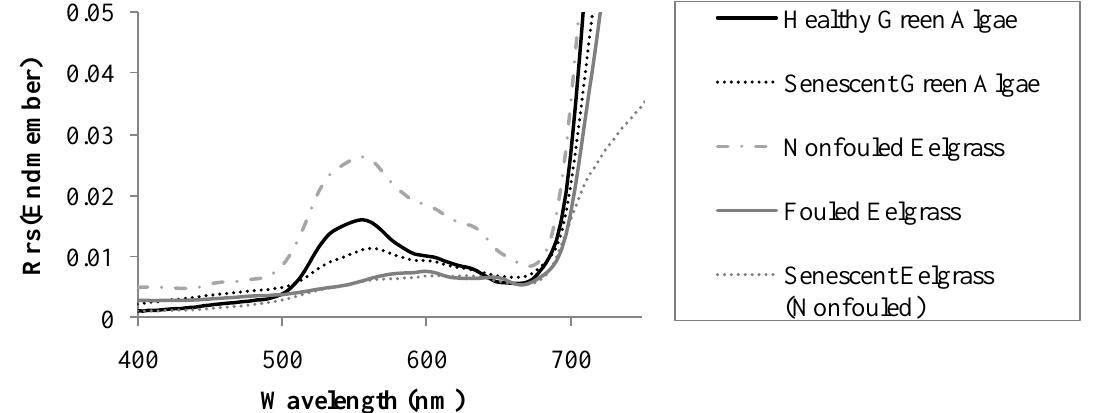
Figure 8. Endmember spectra of healthy and senescent green algae and biofouled, non-biofouled and senescent eelgrass. Classifications exhibit confusion between healthy green algae and non-biofouled eelgrass as well as senescent green algae and bio-fouled